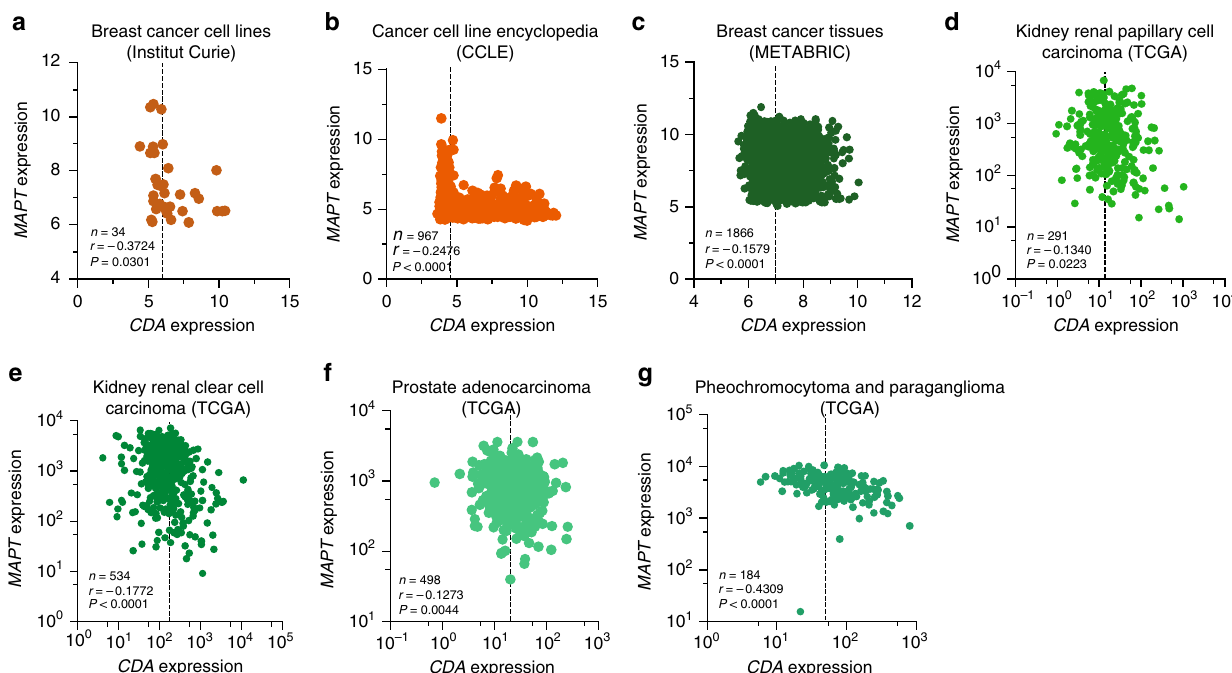
Fig. 5 CDA and MAPT levels are negatively correlated in cancer. Scatterplots showing the Pearson correlation between mRNA microarray data a – c or mRNA sequencing data d – g for CDA and MAPT expression for a Institut Curie breast cancer cell lines ( n = 34), b CCLE (Cancer Cell Line Encyclopedia) cancer cell lines ( n = 967). c METABRIC ( Molecular Taxonomy of Breast Cancer International Consortium ) breast cancer tissues ( n = 1866), and d – g TCGA ( The Cancer Genome Atlas ) four different cancer tissues. Dashed vertical lines correspond to mean CDA expression. P < 0.05 were considered